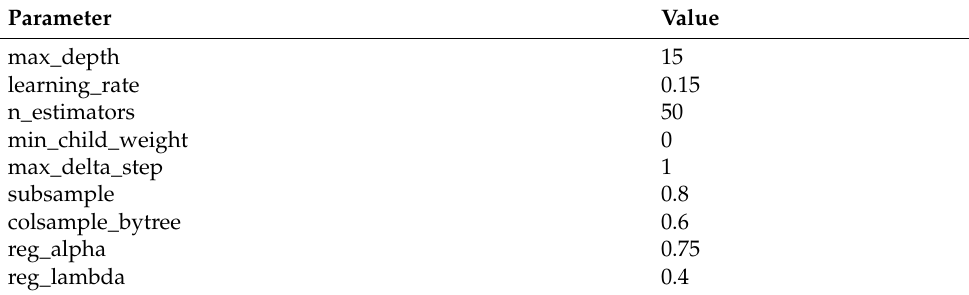
Table 4. Parameters of Xgboost